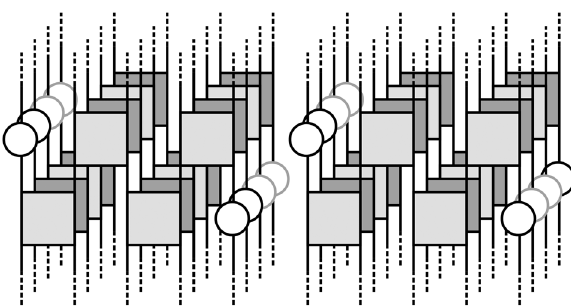
FIG. 28. As in Fig. 27, but here to calculate Z 2 ðþ ; þ ; t Þ (left- hand diagram) and Z 2 ðþ ; − ; t Þ (right-hand diagram). Here, t ¼ 1 . The two copies of the forward evolution operator are shown with light gray, and the two copies of the backward evolution operator are shown in dark gray. Averaging over the single-site matrices fixes a “ þ ” pairing between the copies of the many-body orbits on the left-hand site in both of the diagrams, and also on the right- hand site in the left-hand diagram. In the right-hand diagram, the average imposes a “ − ” pairing on the right-hand